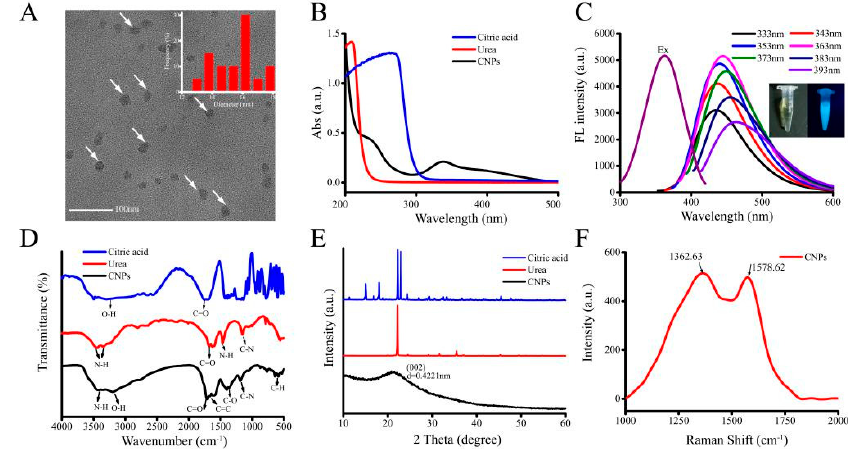
Figure 1. Physical characterization representing the morphology and chemical functionalities using various techniques. ( A ) High-resolution transmission electron microscopy (HR-TEM) image of carbon nanoparticles (CNPs). Inset showing the statistical analysis of the particle size distribution of CNPs. ( B ) The ultraviolet–visible (UV-vis) absorption spectra of CNPs, urea, and citric acid. ( C ) The fluorescence excitation spectra of CNPs and emission spectra of CNPs at the di ff erent excitation wavelengths (inset shows CNPs under visible light, and right shows CNPs excited in UV light). ( D ) Fourier-transform infrared spectroscopy (FTIR) spectra and ( E ) X-ray di ff raction (XRD) patterns of CNPs, urea, and citric acid. ( F ) Raman spectrum of synthesized CNPs.